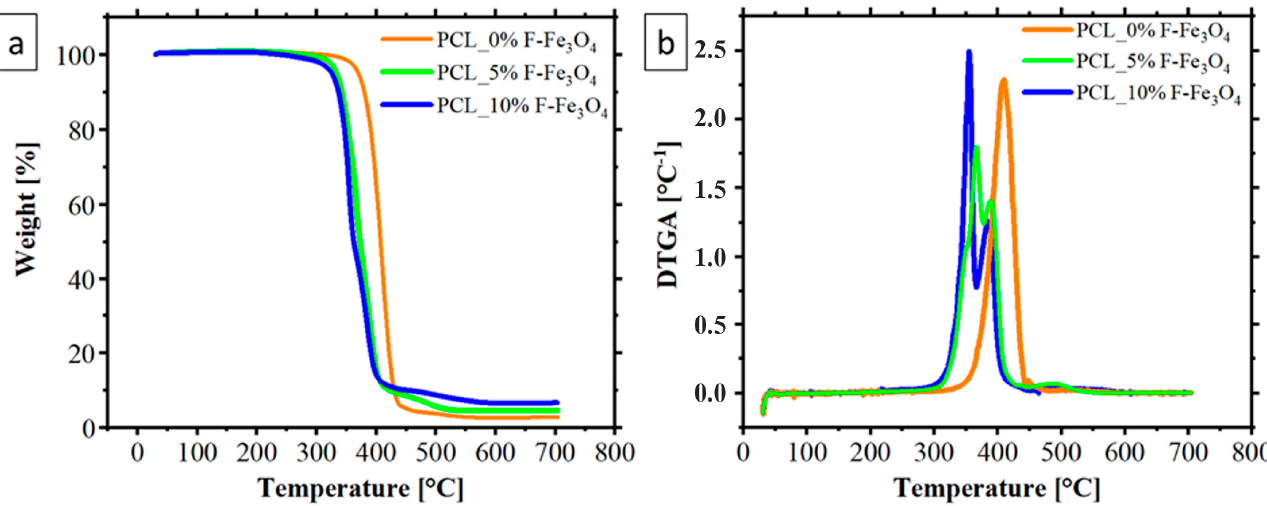
Figure 1. TGA ( a ) and DTGA ( b ) of PCL membranes loaded with F-Fe 3 O 4 nanoparticles. DSC analyses evidence that these types of systems are thermally stable (no transitions) around human body temperature. In fact, PCL, which is characterized by a low melting point (around 60 ◦ C), tends to increase the melting temperature by increasing the F-Fe 3 O 4 amount. The DSC graph is reported in Figure